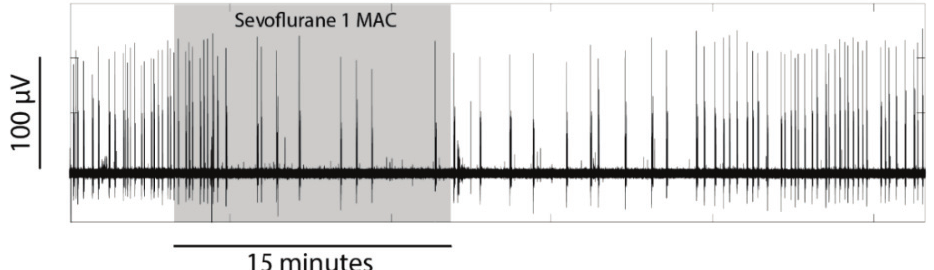
Figure 7. Example from one slice showing the reversible inhibitory e ff ect of sevoflurane on seizure-like event (SLE) activity. The shadowed region represents the period of drug